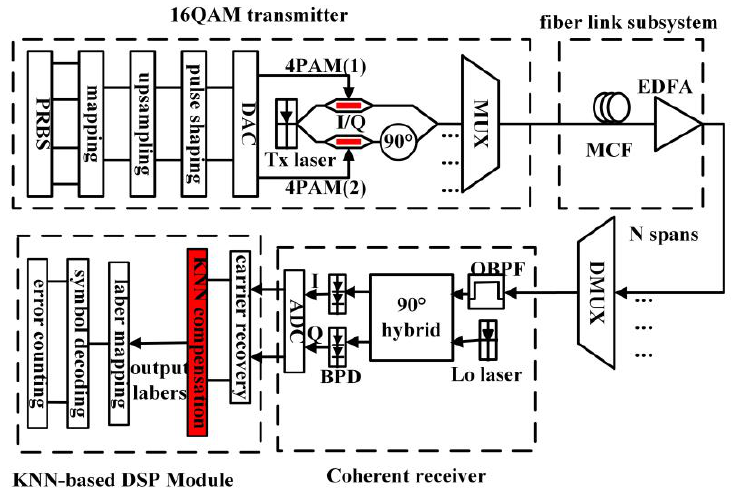
Fig. 3. Model diagram of 16QAM signal transmission through seven-core optical fiber.